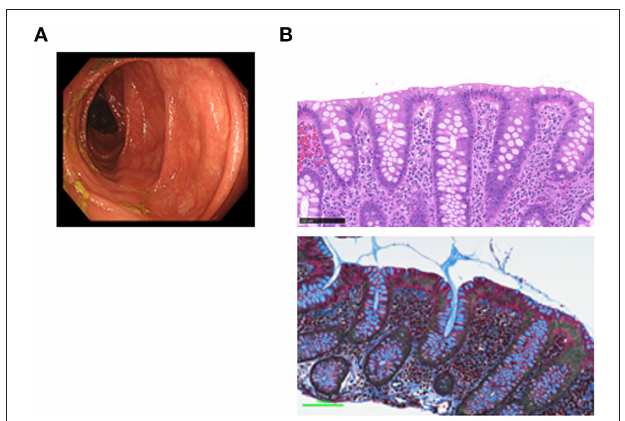
FIGURE 2 | Endoscopic and pathological findings in a patient with collagenous colitis in the remission phase. (A) Colonoscopic examination revealed vascular networks without mucosal edema in the transverse colon. (B) Pathological examinations of the transverse colon biopsy samples revealed the absence of the subepithelial collagen band that was present during the active phase (Masson’s trichrome staining, bottom), whereas the accumulation of immune cells in the lamina propria was still observed (hematoxylin and eosin, H&E staining, top). Scale bar, 100 µ m. Magnification ×